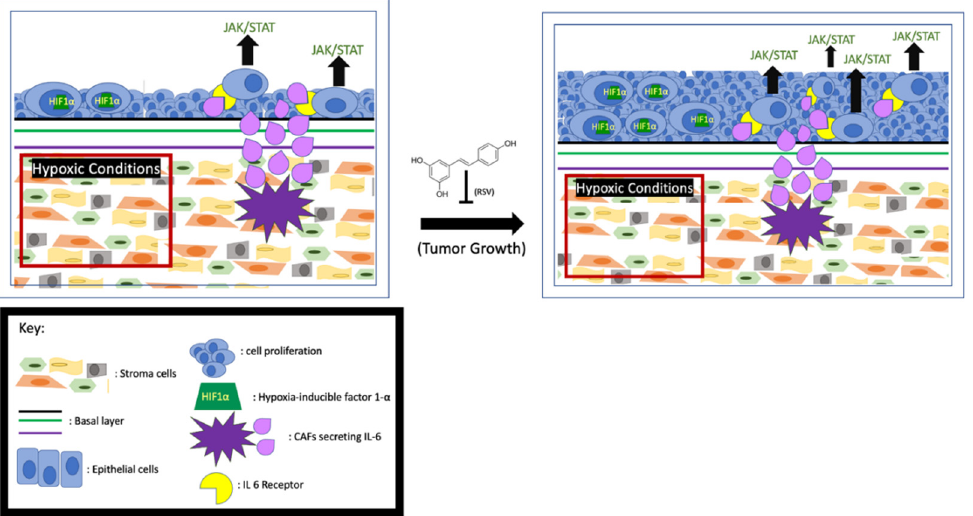
Figure 2. RSV inhibits prostate cancer proliferation. Hypoxia-induced HIF1 α and activation of JAK/STAT by the CAFs- secreted IL-6 enhance tumor growth, and RSV is capable of inhibiting cell proliferation.